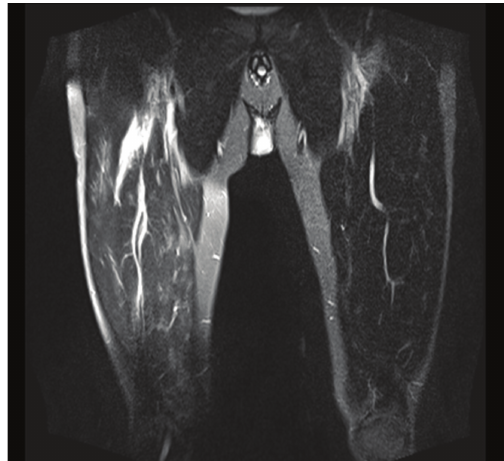
Figure 1: Coronal STIR MRI image showing high signal change in the right thigh associated with intramuscular oedema.